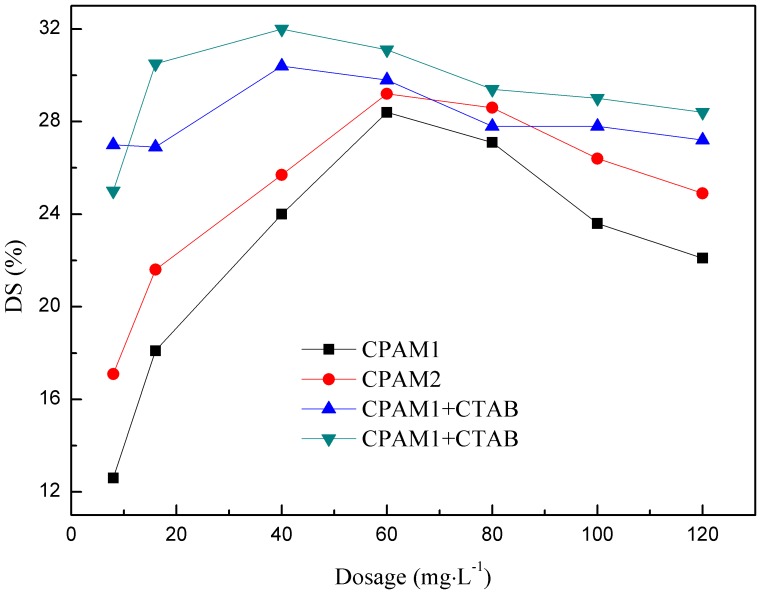
Effect of flocculant dosage on DS content.